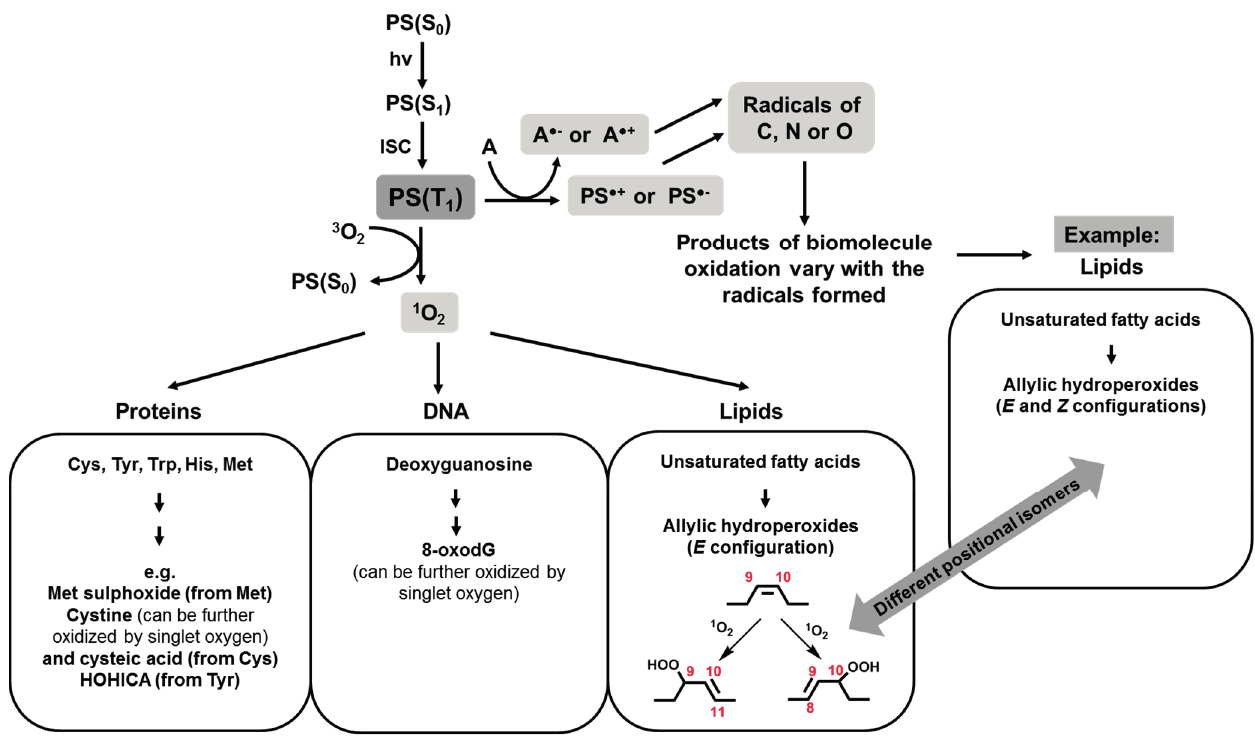
Figure 1. Main routes and initial products of singlet oxygen and radical mediated photooxidations (for details on the products formed, refer to citations in the main